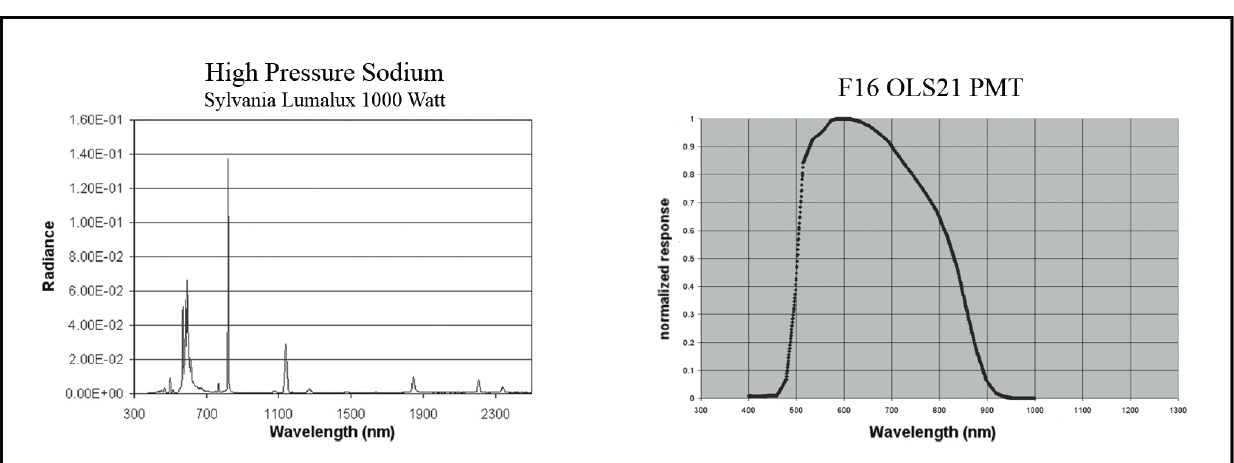
Figure 1. Spectral Signature of Lamp and Spectral Response of Defense Meteorological Satellite Programs’ Operational Linescan System (DMSP OLS) F16